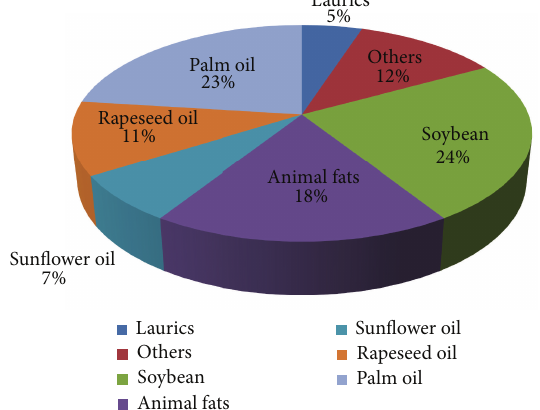
Figure 3: Production of biodiesel from different feed stock